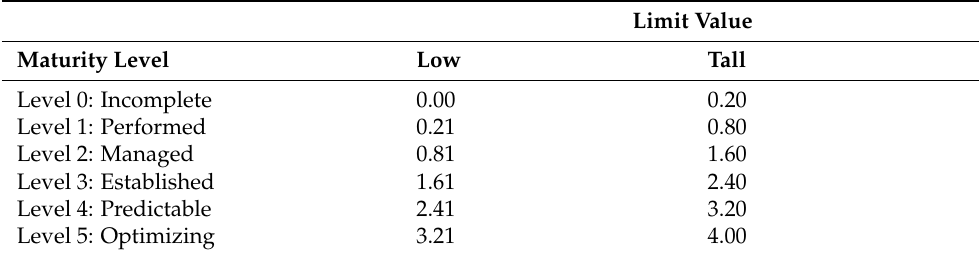
Table 5. Limit value to determine maturity